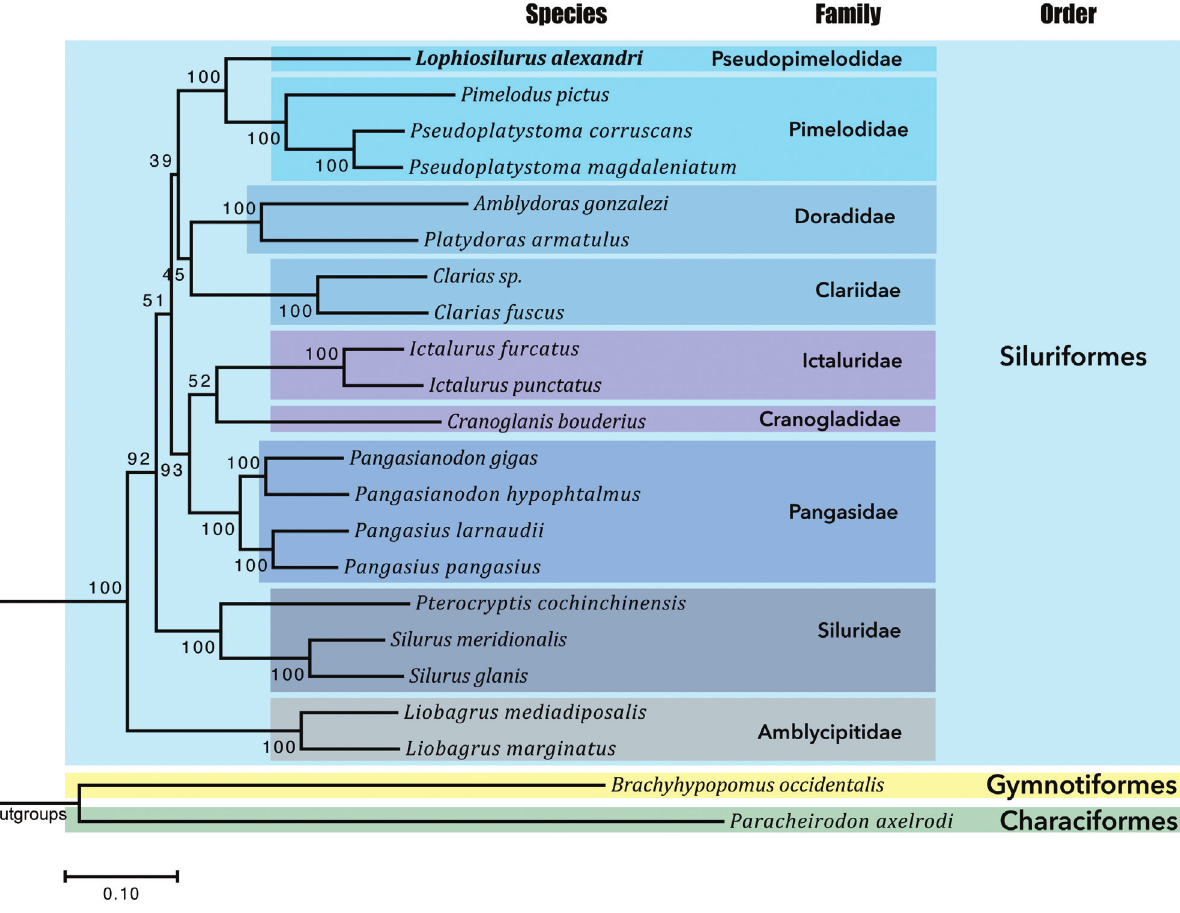
Figure1 -Molecularphylogeneticanalysisofpacamã,20catfishesandtwooutgroups.Atotalof11,468positionswereanalyzedconsistingintheconcat- enation of 13 mitochondrial genes. A tree was built using maximum likelihood approaches with GTR+G+I model. Outgroups were used to root the tree. All families and genera of catfishes analyzed were revealed as monophyletic (colored boxes). Bootstrap values (1000 replicates) are shown at the corre- sponding